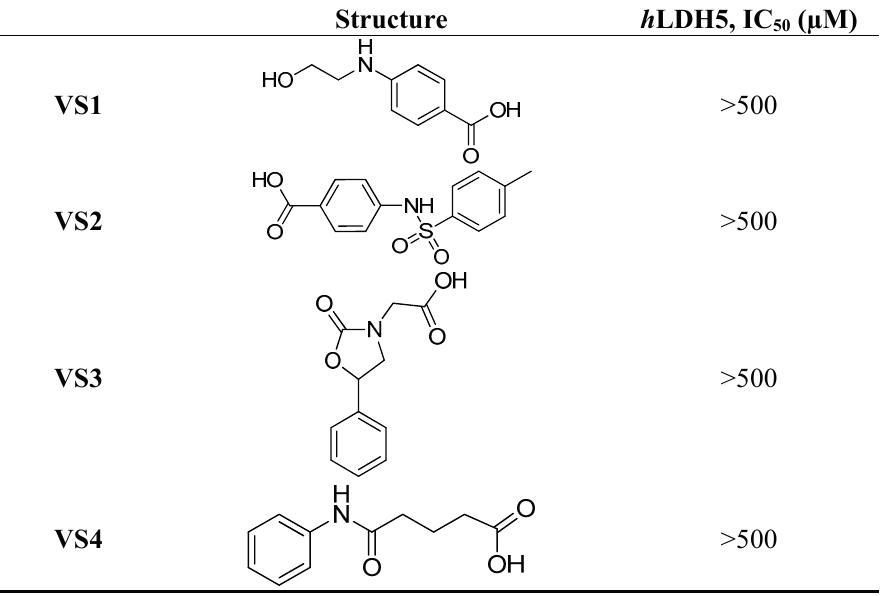
Table 2. Structure and activity of the tested